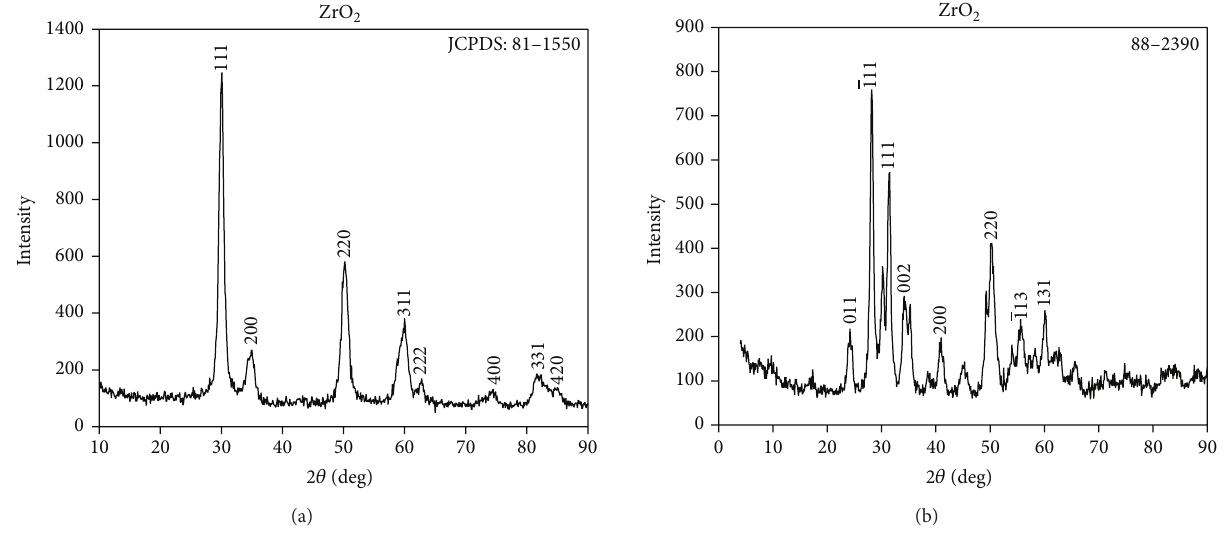
Figure 1: (a) and (b): XRD pattern of coarse zirconia and synthesized